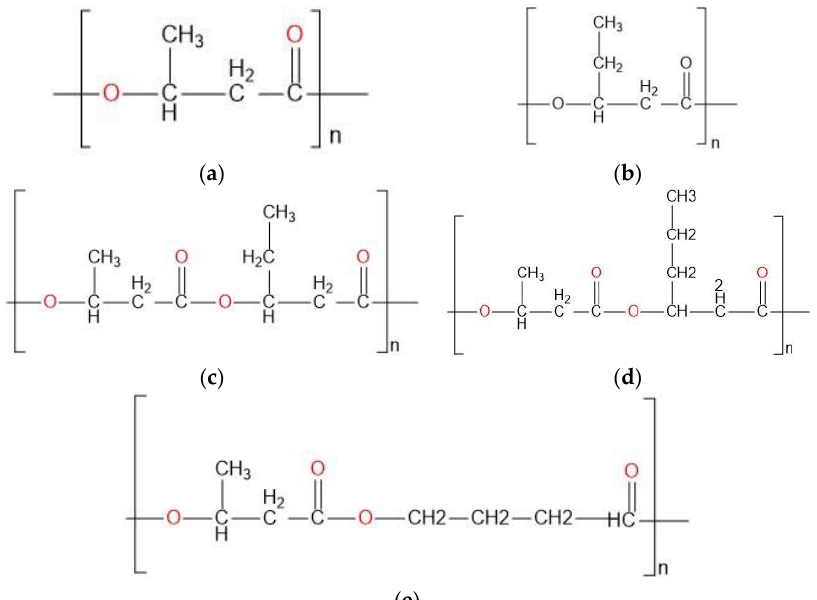
Figure 1. Polyhydroxyalkanoates used in industry. ( a ) Polyhydroxybutyrate (PHB); ( b ) Poly- hydroxyvalerate (PHV); ( c ) Poly (3-hydroxybutyrate-co-3-hydroxyvalerate)(PHBV); ( d ) Poly (3-hydroxybutyrate-co-3-hydroxyhexanoate; P(3HB-co-3HHx)); ( e ) Poly (3-hydroxybutyrate-co-4- hydroxybutyrate)